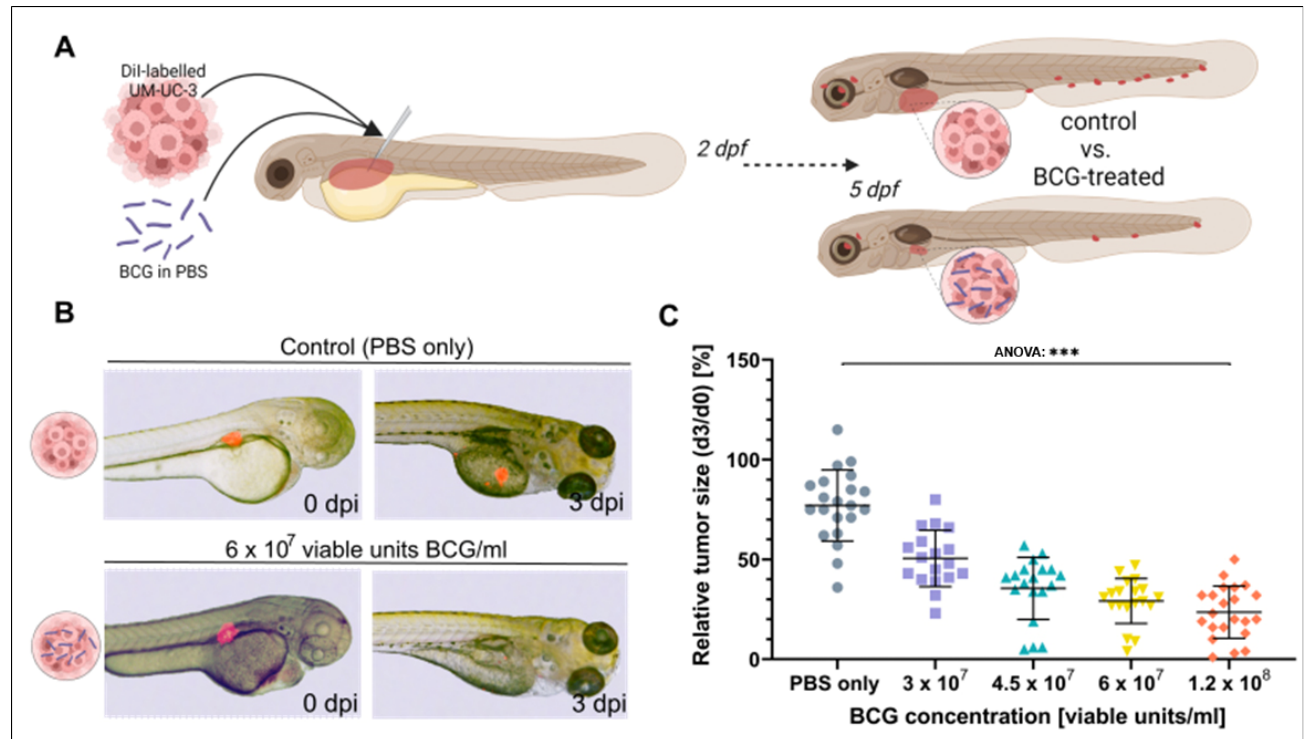
Figure 2. Tumor size regression of UM-UC-3 tumors is observed in zebrafish xenografts after three days of BCG treatment. ( A ) Cartoon illustrating the experimental setup. DiI labelled UM-UC-3 tumor cells mixed with BCG were subcutaneously microinjected into zebrafish larvae 2 days post- fertilization and primary tumor size was monitored until 3 days post injection (dpi). ( B ) Combined light- and fluorescence micrographs of 2-day-old zebrafish larvae implanted with fluorescently labelled primary tumors of control (UM-UC-3 + PBS) and BCG at 0 days post injection (dpi) and 3 dpi. ( C ): Graph showing the relative tumor size of control and BCG-co-injected larvae for 4 different concentrations of BCG-Medac. n = 24 injected embryos per group; *** = p < 0.0001.